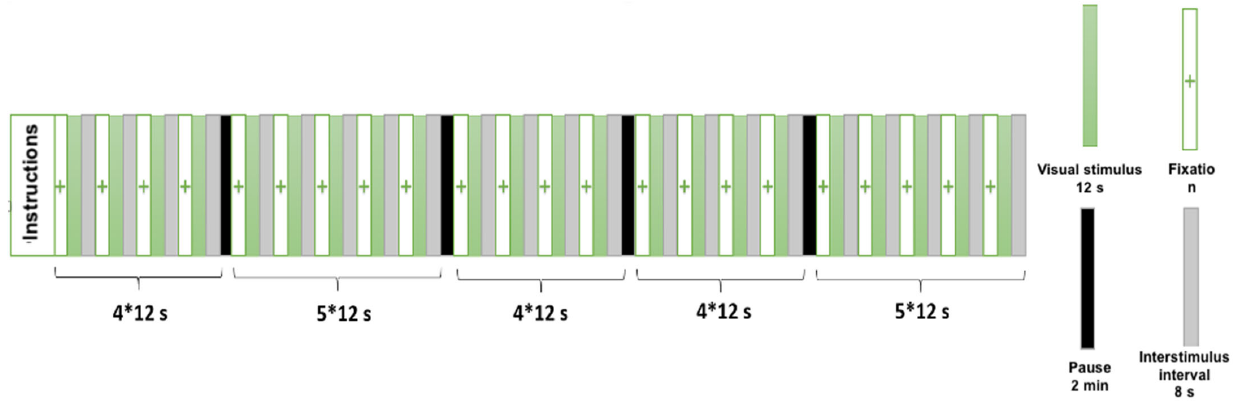
Figure 1. Temporal course of experimental session.